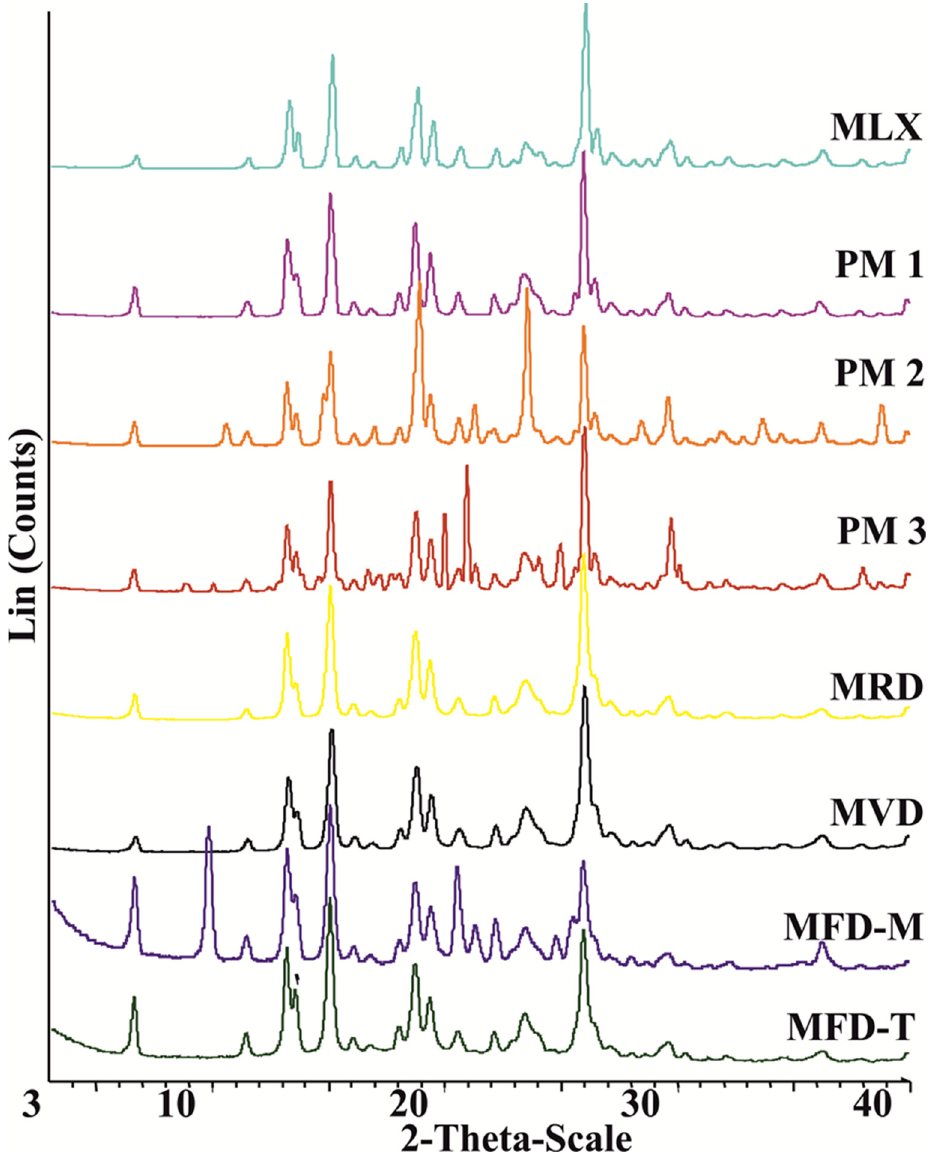
Figure 3. XRPD thermograms of a) MLX-related samples of raw MLX, PM1 (MLX: F68, 5:1), PM2 (MLX: F68: M, 5:1:3), PM3 (MLX: F68: T, 5:1:3), and freeze-dried nanocrystals.